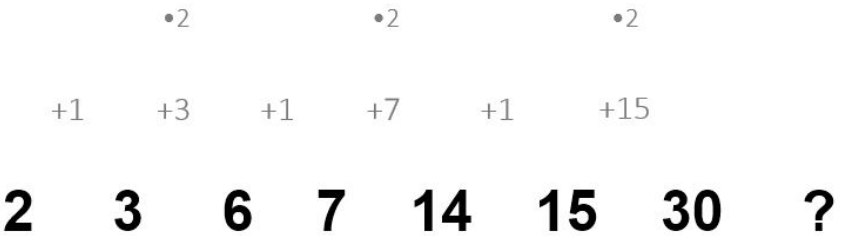
Figure 1. Illustrative example of a number series item with a large number of notated